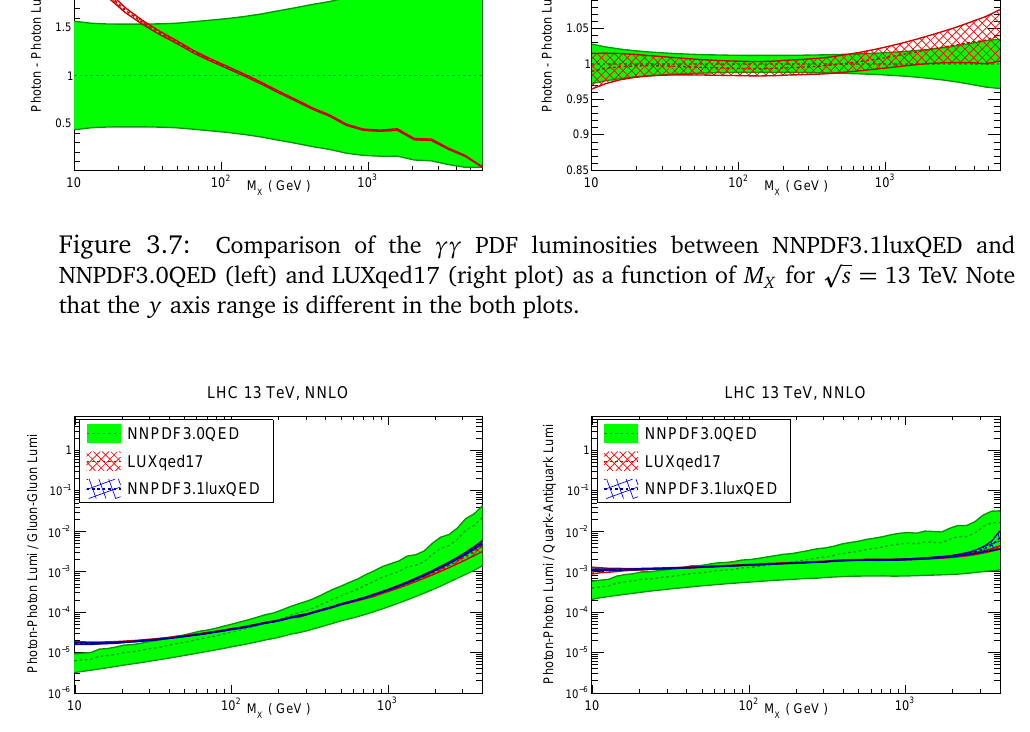
/ (right plot) ratios of PDF γγ L L q ¯ q